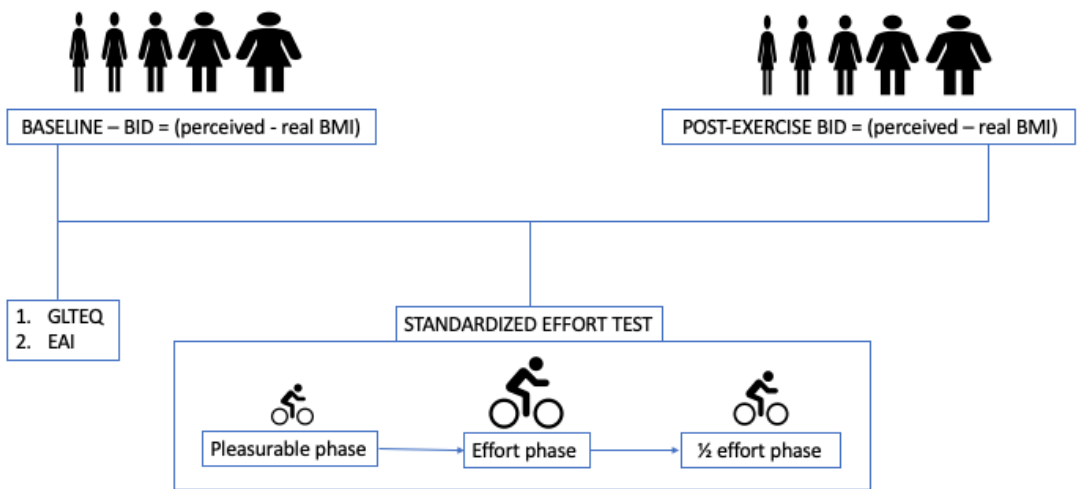
Figure 1. Protocol of the study. Participants were invited to choose the silhouette resembling their own body image before and after a standardised effort test aimed at obtaining the same amount of effort from all participants. BID = body image distortion. BMI = Body Mass Index. GLTEQ = Godin Leisure Time Exercise Questionnaire. EAI = Exercise Addiction Inventory.